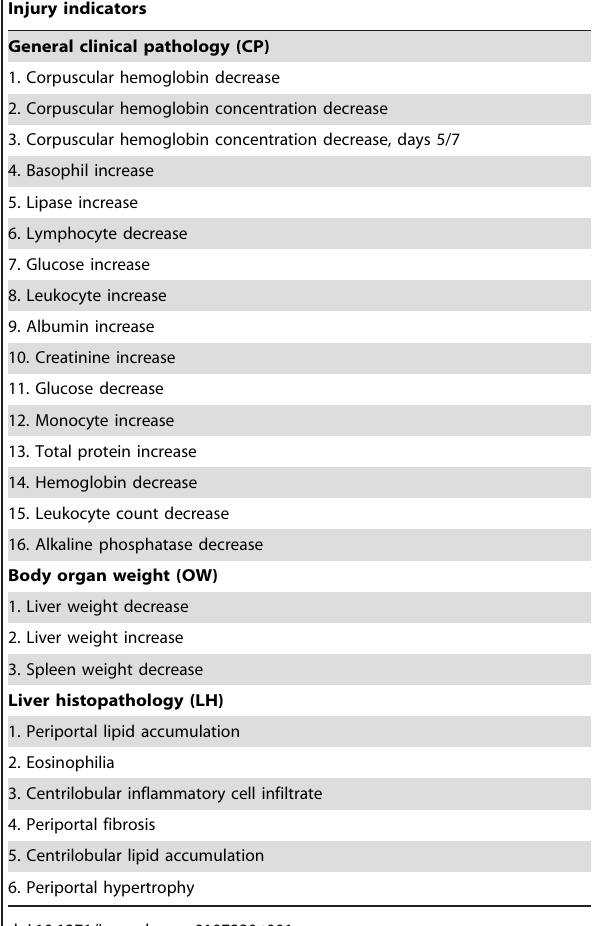
Injury indicators General clinical pathology (CP)